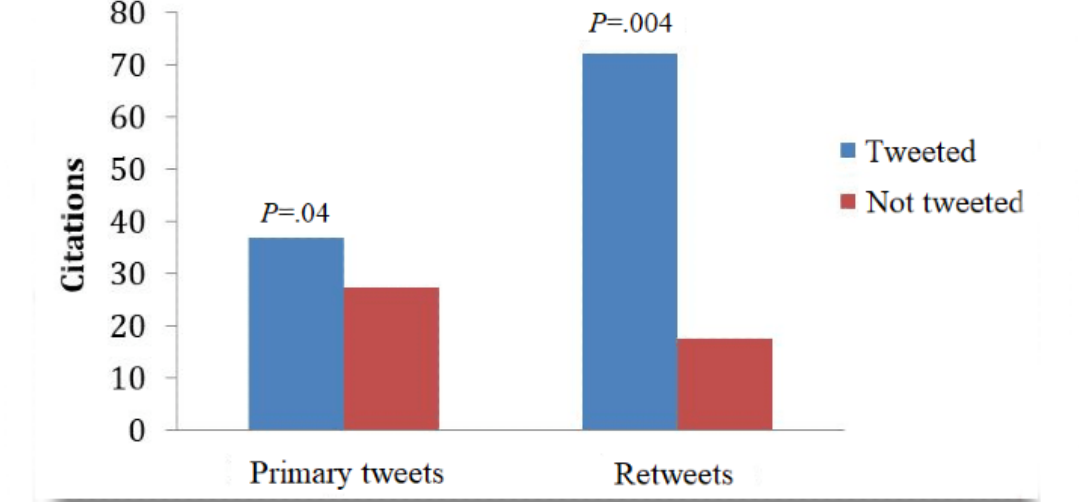
Figure 1. Comparison of citations between articles that were tweeted and those that were not tweeted. Primary tweets: analysis of all manuscripts (n=1666) comparing tweeted articles and nontweeted articles; retweets: analysis of all tweeted manuscripts (n=477) comparing articles that were retweeted at least once and articles without retweets.